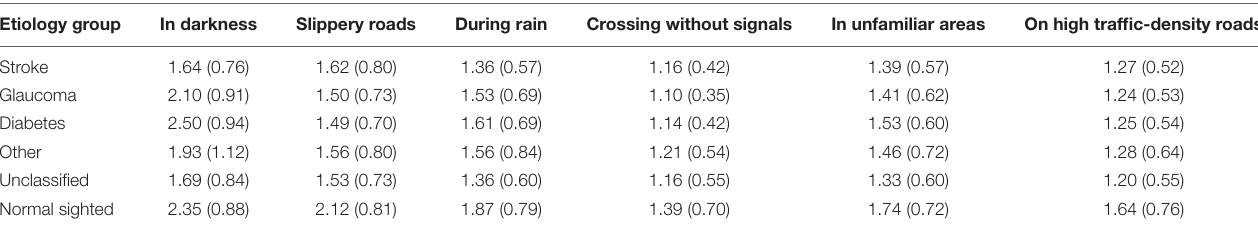
TABLE 3 | Six traffic situations (mean values (and standard deviations)) with significant effects of VFL etiology and significant pairwise comparisons. Etiology group